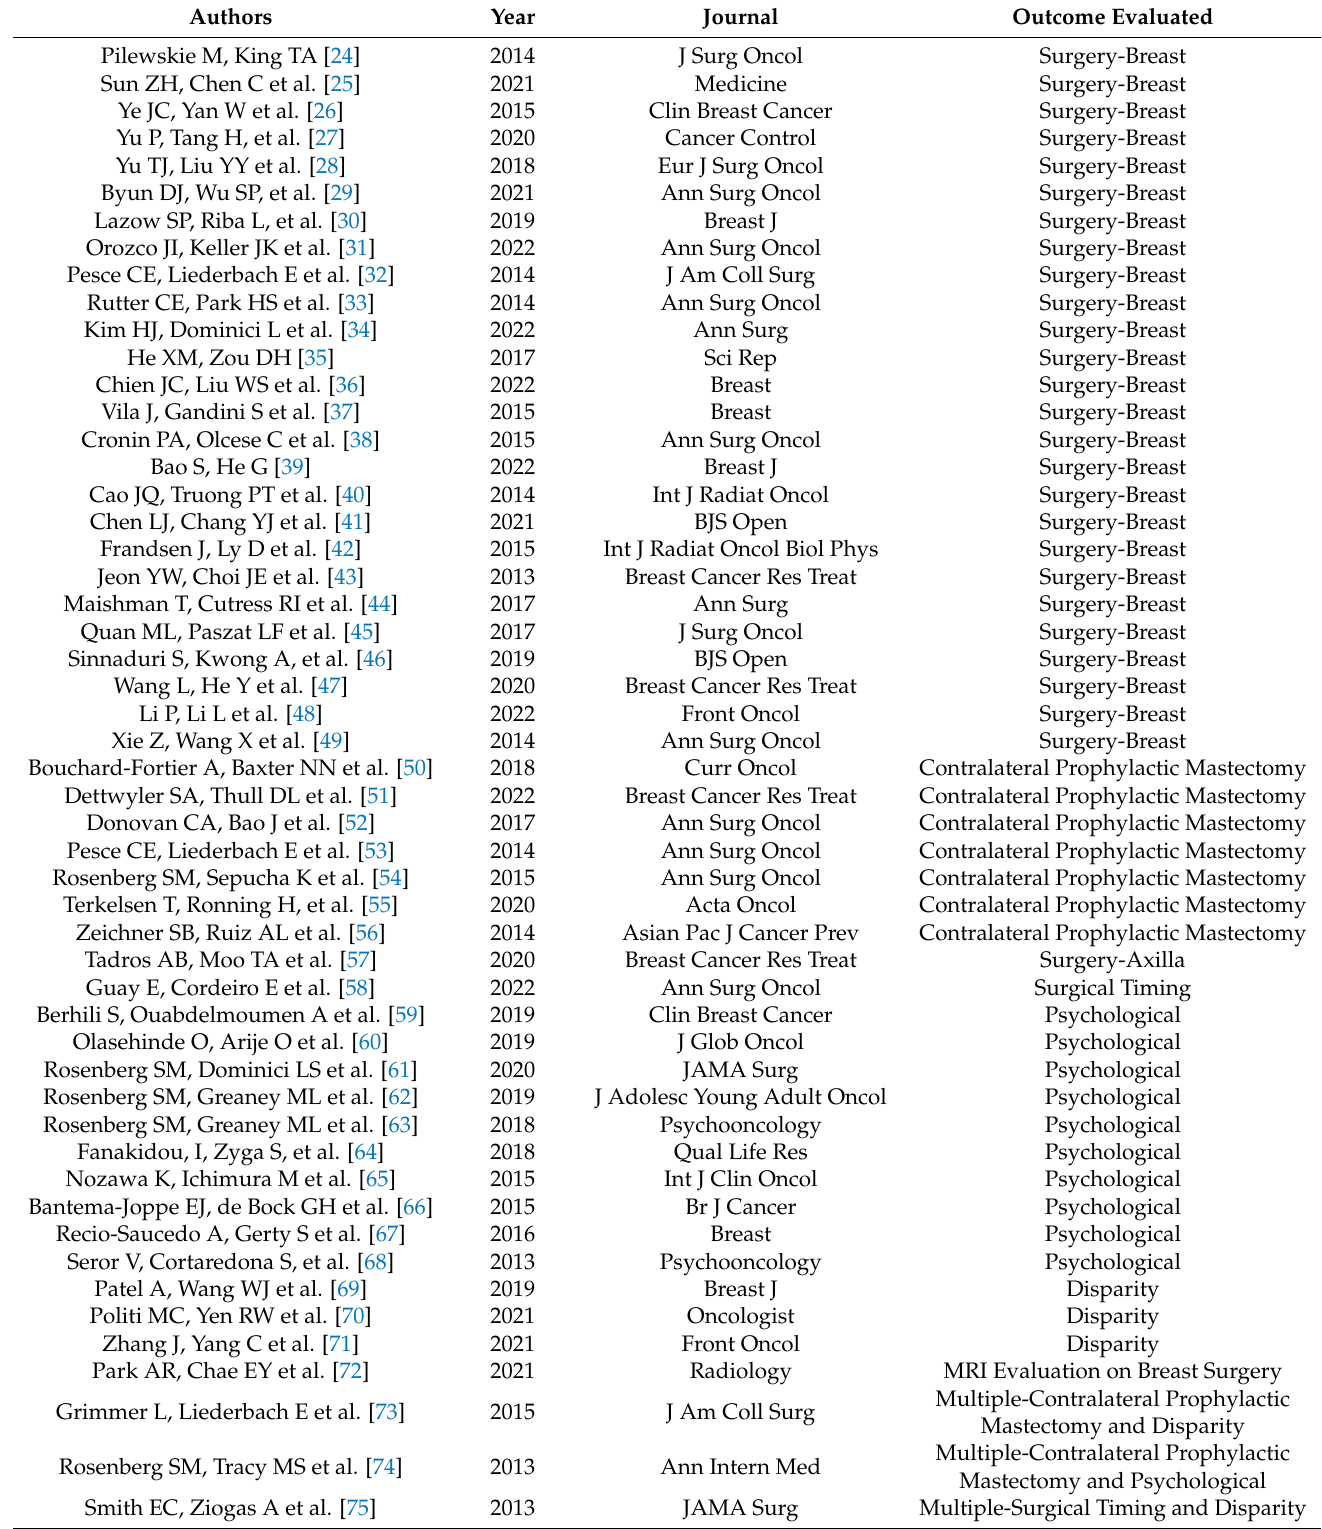
Table 1. Studies included in the literature